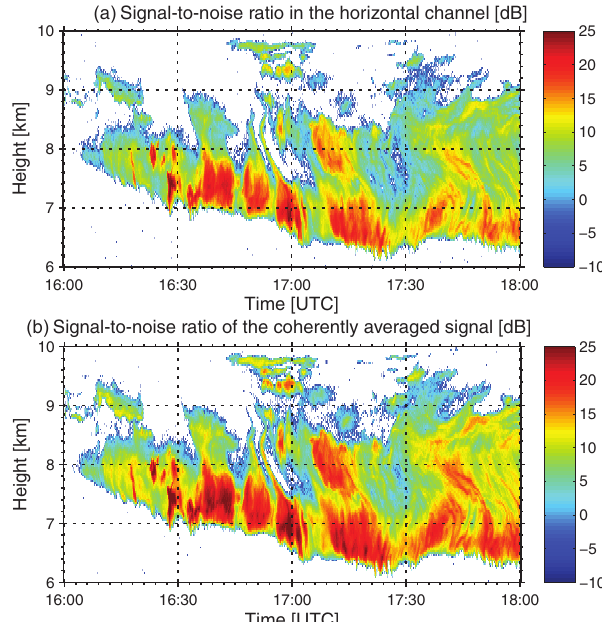
Figure 7. Time–height cross sections of signal-to-noise ratios cal- culated from B hh (a) and B cc (b) measured at Elmshorn, Germany, on 1 May 2014. The number of data points (especially in high-level clouds) in panel (b) is higher in comparison with (a) because of higher